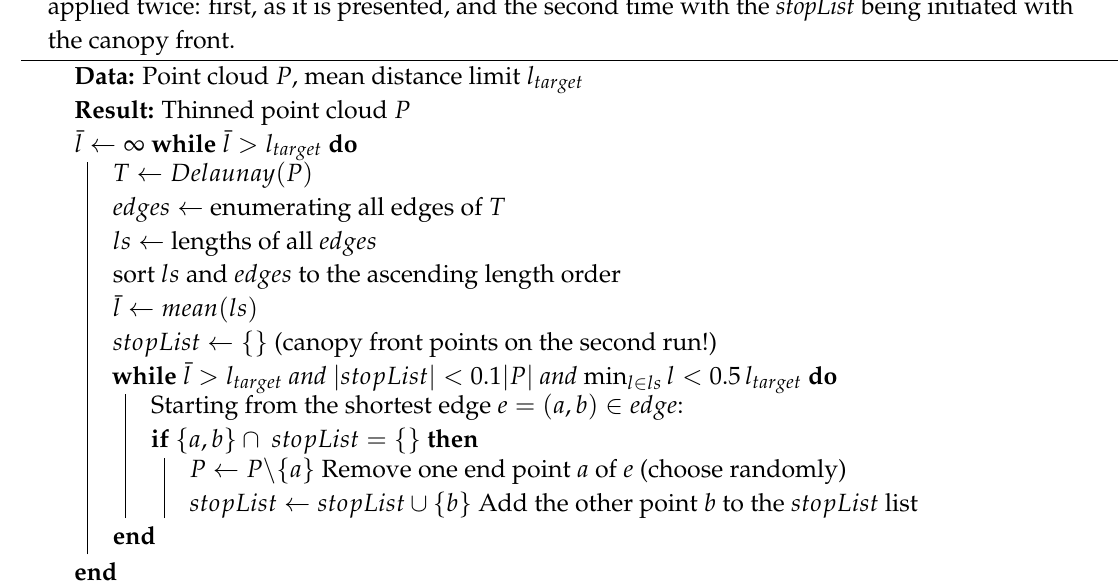
Algorithm 1: Thinning the point iteratively making the mean neighborhood distance